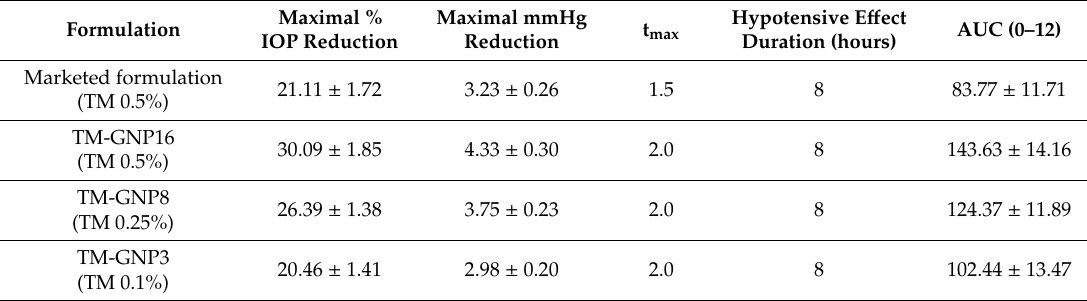
Table 4. p -values obtained after one-way ANOVA comparison between the reference commercial formulation and timolol-loaded nanoparticle formulations. (* significant di ff erences p < 0.05). AUC (0–12)